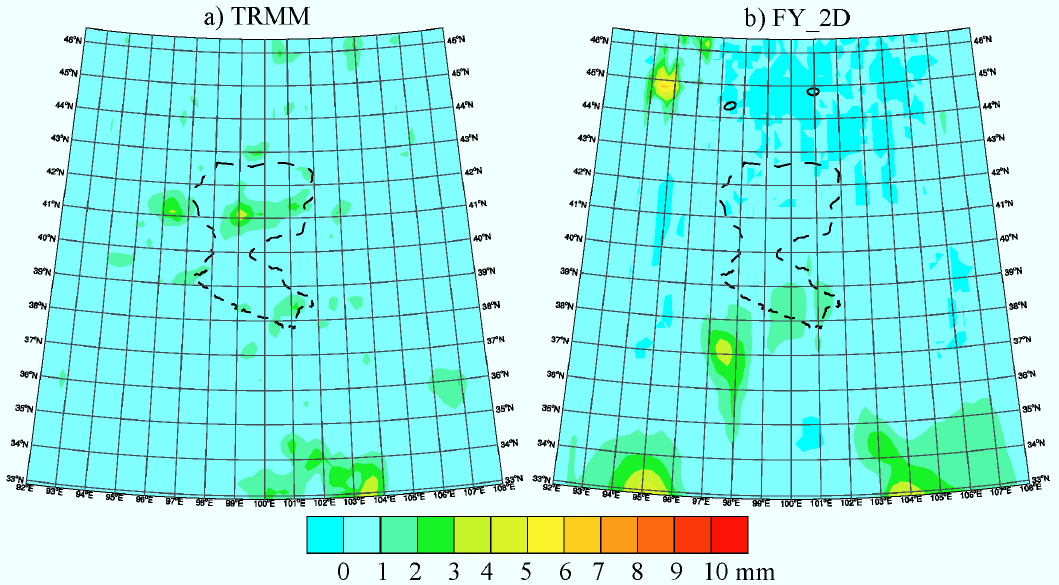
Figure 3. Spatial distributions of accumulated remote sensing precipitation from 00:00 UTC to 06:00 UTC on 21 June 2008, over the first domain: ( a ) TRMM 3b42 V6 precipitation product; ( b ) FY-2D precipitation product.